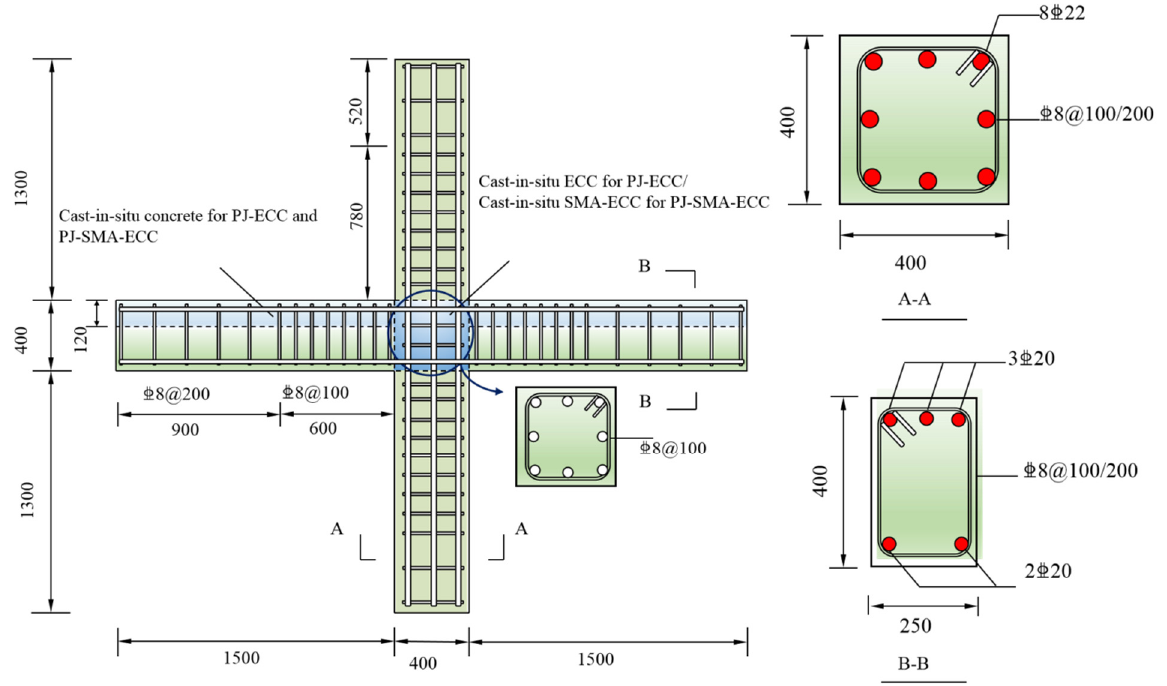
Figure 1. Details of joint specimens (unit: mm).